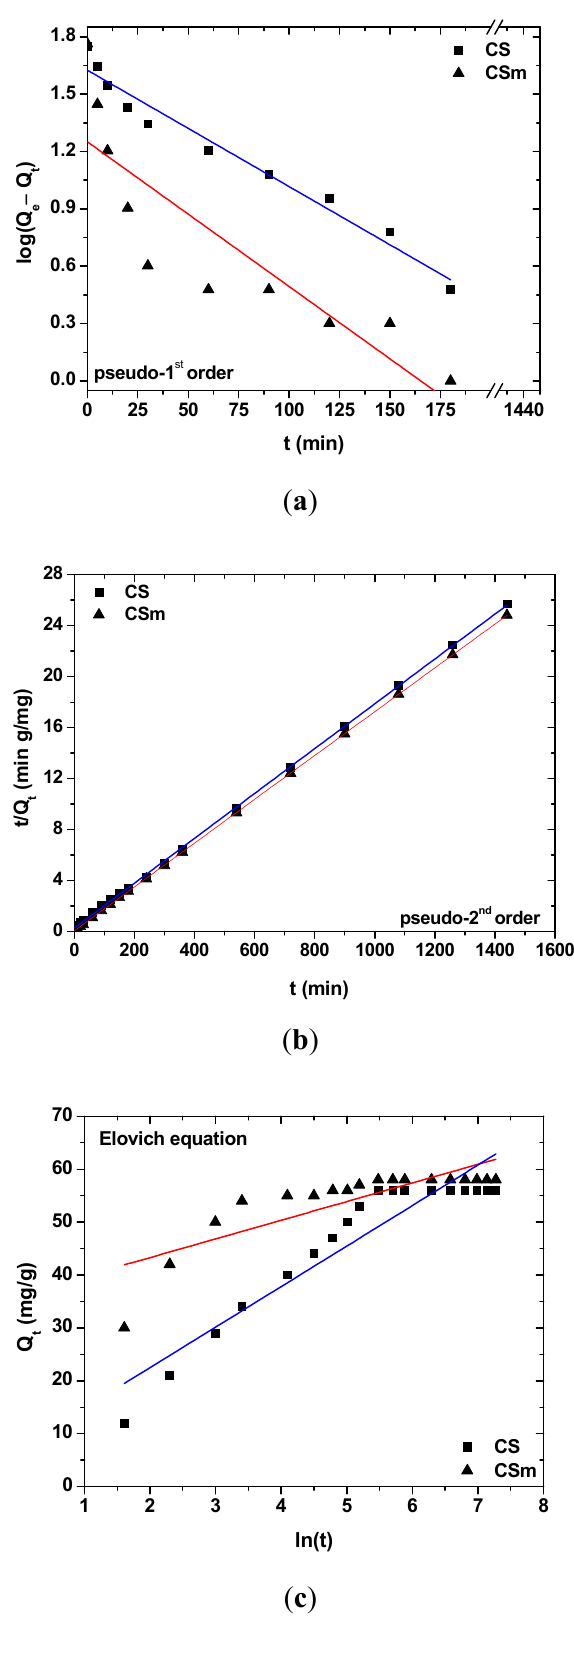
Figure 9. Effect of contact time on adsorption of Hg(II) onto CS and CSm: fitting